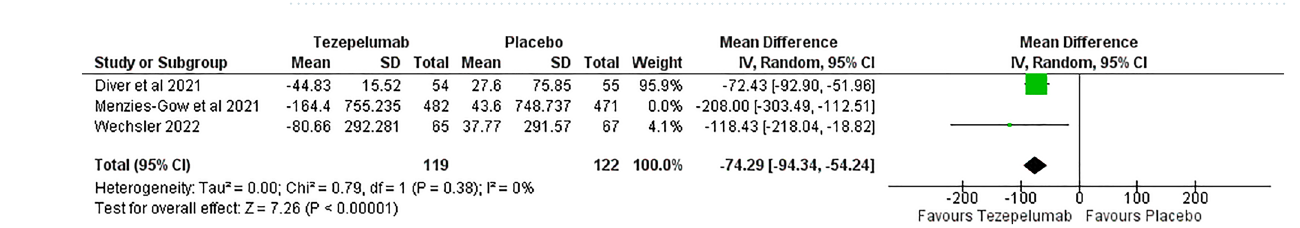
Figure 9. Change from the baseline in FeNO.